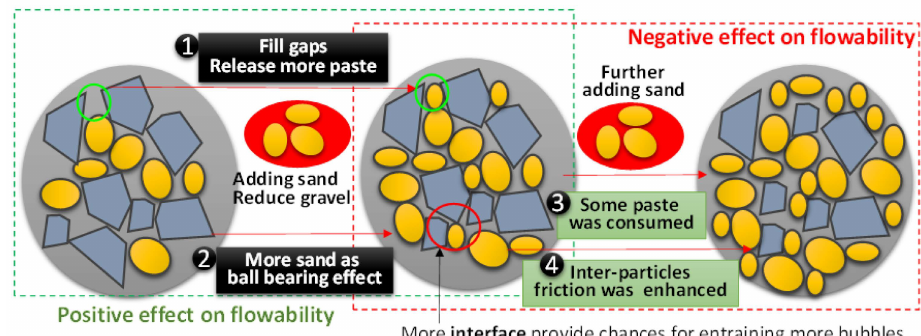
Figure 7. Schematic of the effect of sand ratio (SR) on the